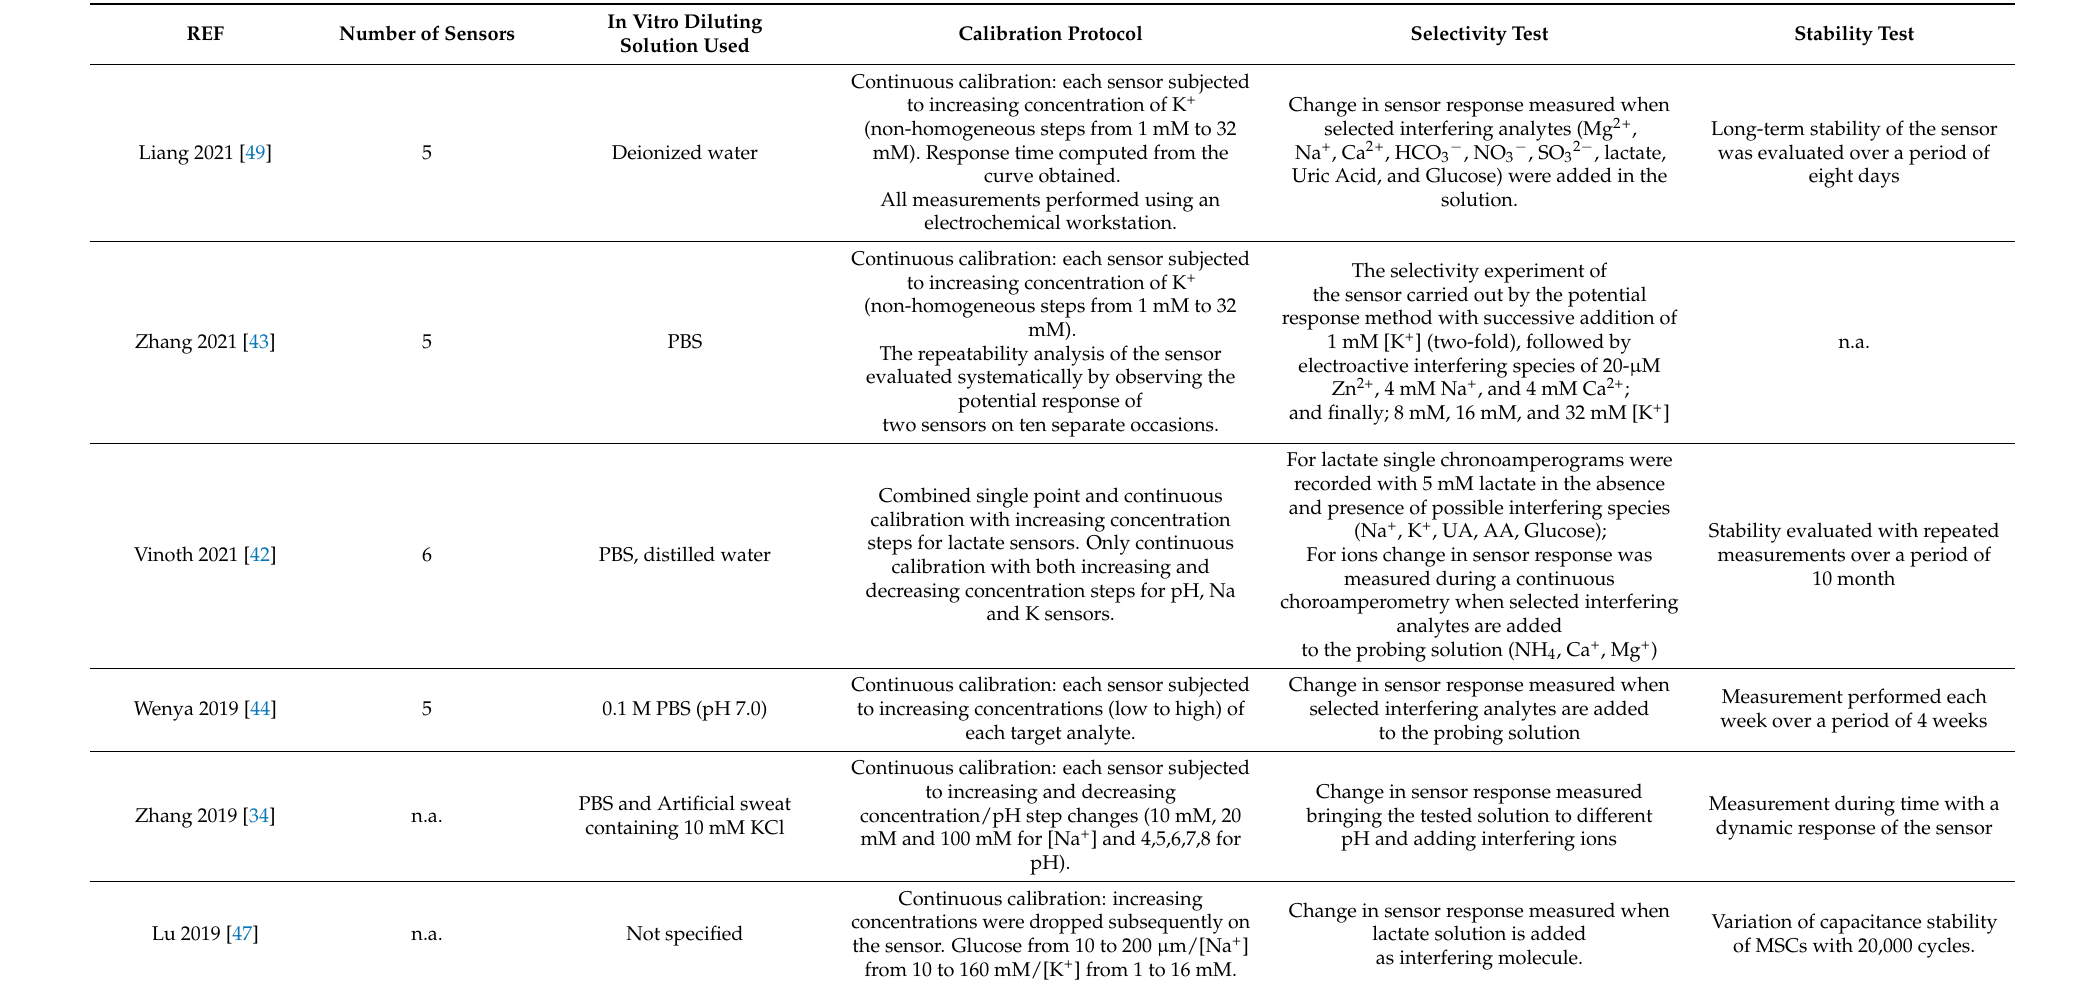
Table 3. Summary of in vitro characterization